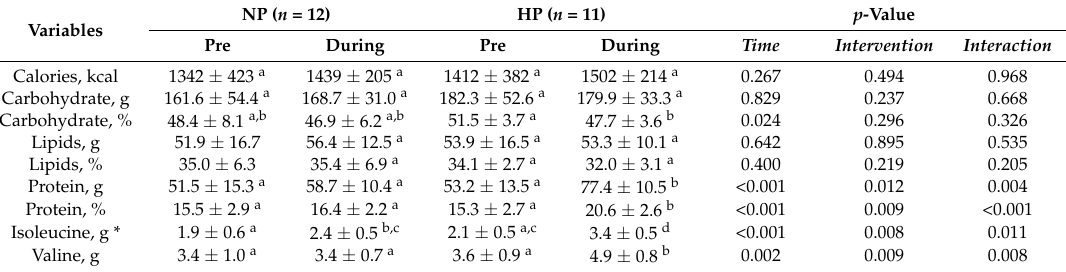
Table 2. Intake of calories, macronutrients, and BCAAs according to moments and groups